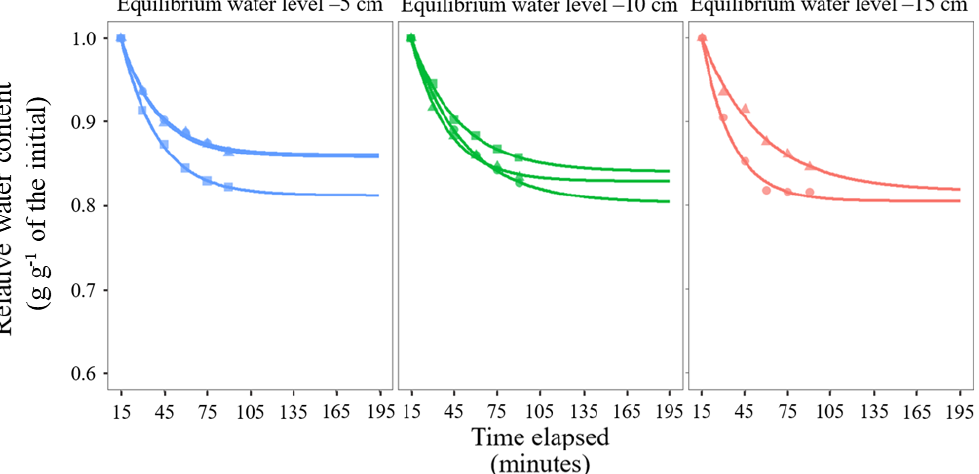
Figure 4. Time series of relative water content (g g –1 of the initial weight) of Sphagnum palustre (five capitula) from Iwate after installation in the moisture-control equipment ( n = 3, but only 2 at -15 cm water level). Different symbols (closed circle, triangle, square) represent results for different samples.